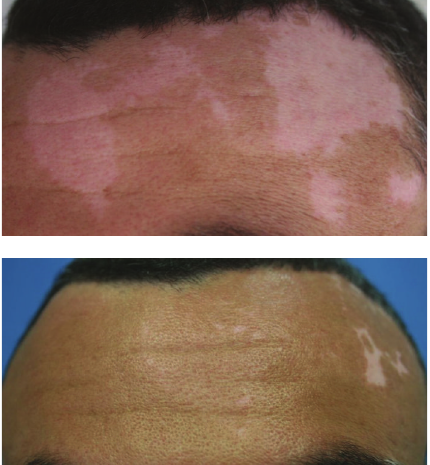
Figure 1: Repigmentation observed after melanocyte transplanta- tion for the treatment of stable